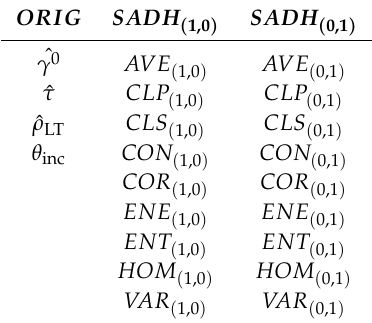
Table 1. List of the 22 features considered in Section 5. Column ORIG shows the parameters used in [7], while columns SADH ( 1,0 ) and SADH ( 0,1 ) explain the textures extracted by using displacement vectors along both the azimuth d = ( 1,0 ) and the slant-range d = ( 0,1 ) directions, respectively, whose mathematical formulation is presented in Equations (4)–(12). ORIG SADH ( 1,0